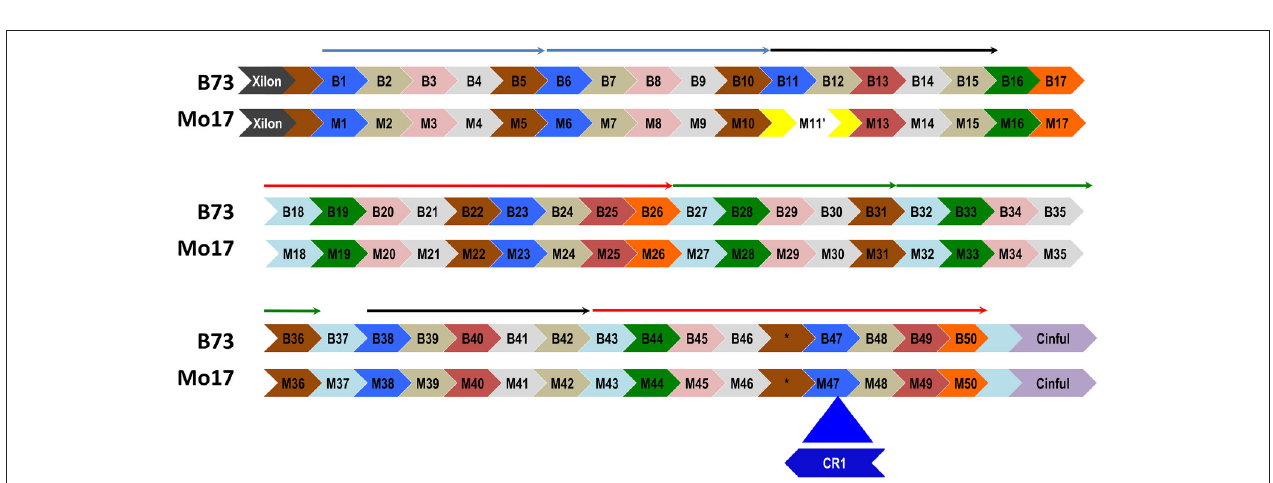
FIGURE 5 | A recently created CentC HOR is an adjacent duplication. The youngest (98 kya) of four dated CentC HORs in CEN10 (circled in Figure 1 ) is a 10-monomer adjacent segmental duplication. (A) JV annotation of the duplicated left (L) and right (R) HOR segments with monomers numbered in order. Monomer coordinates are given in Table S6 (2A and 2B). The R HOR is disrupted by a CR1 with identical LTRs (estimated insertion time 0–25.5 kya). (B) The L and R monomers are shown in a neighbor-joining tree to indicate that most similar monomers are at equivalent positions in L and R. Bootstrap (1,000) percentages at branch points are shown. The scale represents nucleotide differences. Only monomer pairs 5 and 7 are identical–monomers 3L and 3R differ by one indel. JV annotations: CentC green, CR1 LTR blue, CDS tan.